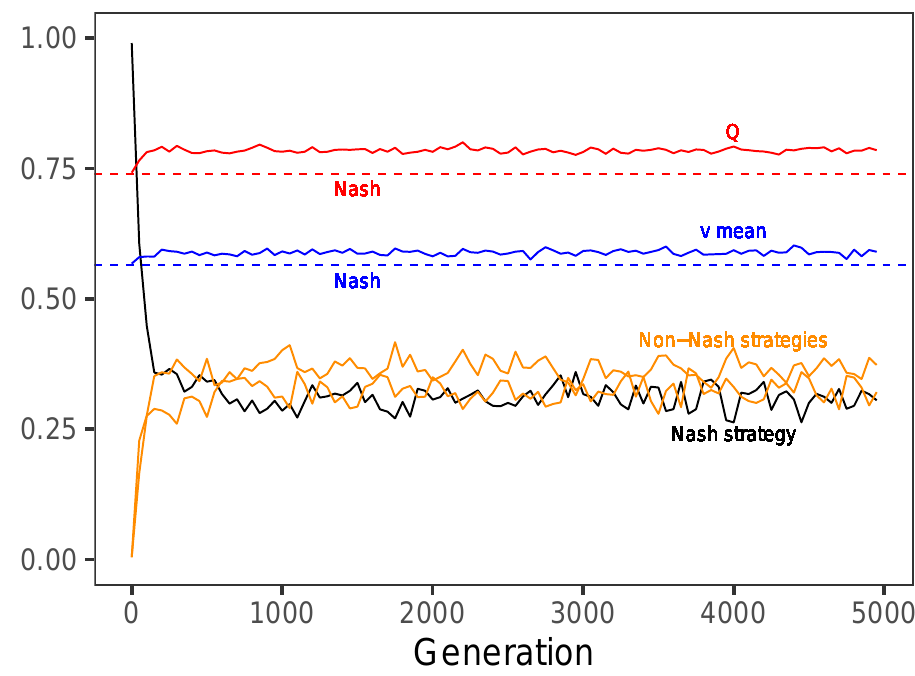
Figure 6 – Simulation of mixed strategies, with c = 0.3 and K = 4 . The black line shows the frequency of the Nash strategy, and the orange lines show those of two mixed strate- gies that differ from the Nash. The red line shows the frequency, Q , with which individ- uals went fishing, and the blue line shows the mean value, ¯ v , of the berry patch at the time it is harvested. The two dashed lines show the values of Q and ¯ v at the NE. The population consisted of 2000 groups.